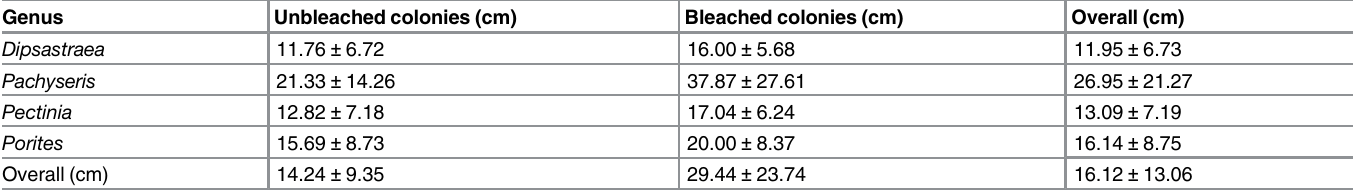
Table 4. Mean maximum diameter ( ± SD) of the corals from the four genera with the most number of bleached colonies.